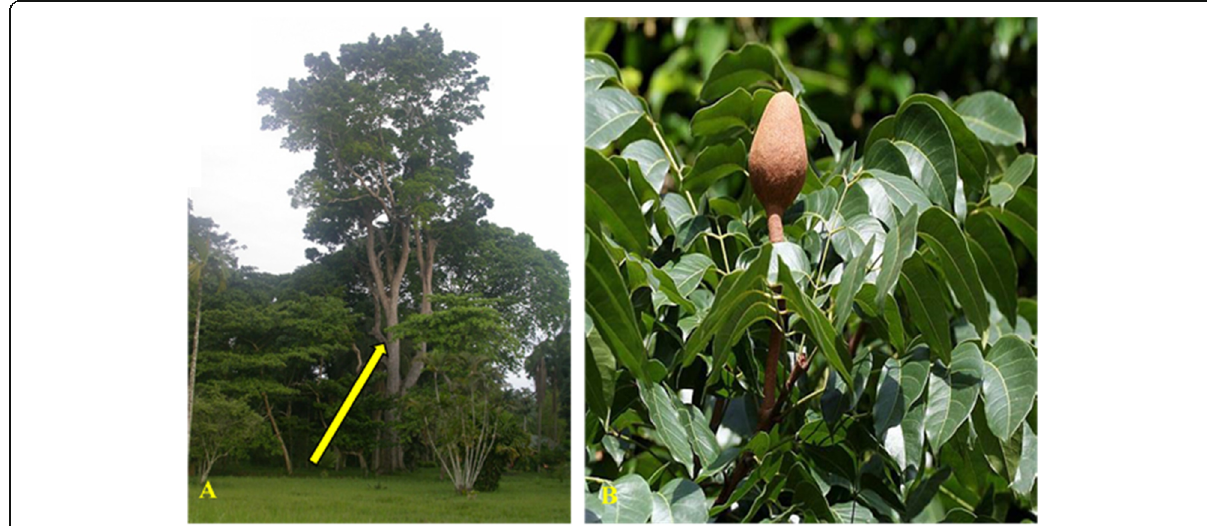
Fig. 4 K . ivorensis . a Tree. b Leaves. Source: Google images